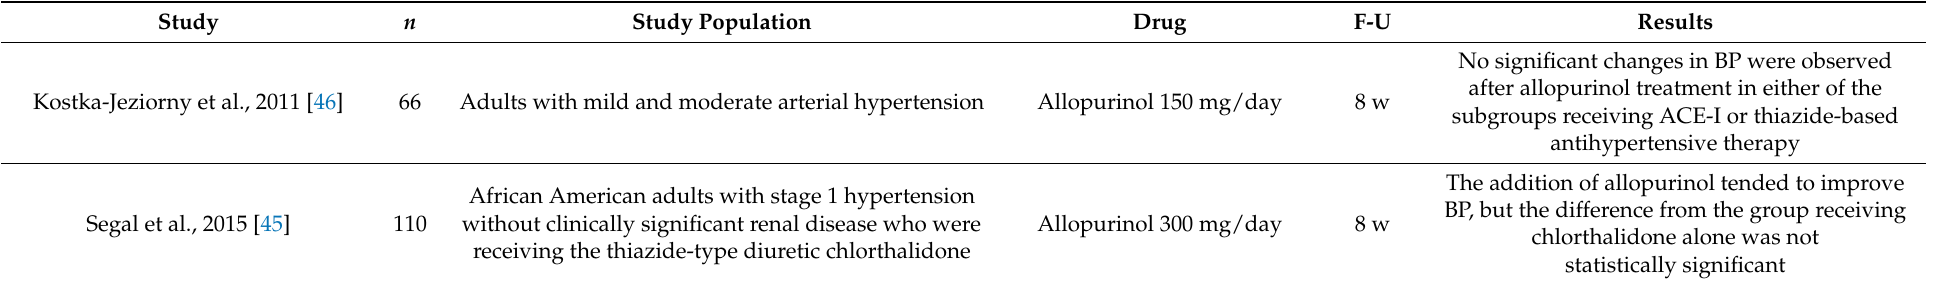
Table 2. Studies on the effects of UA-lowering drugs on